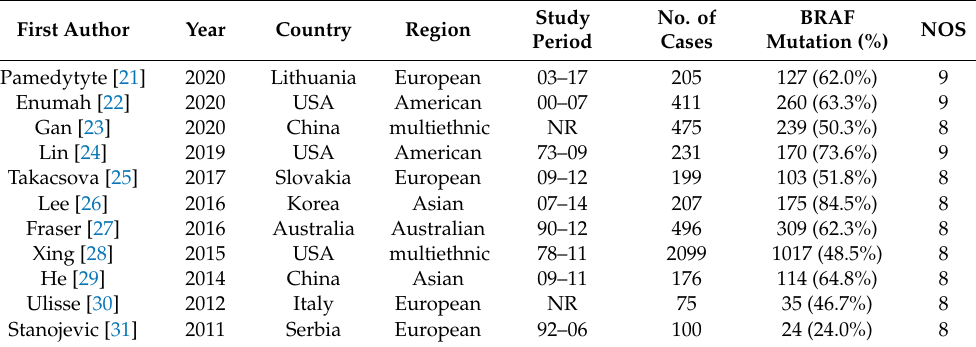
Table 1. Characteristics of the studies included in the meta-analysis.